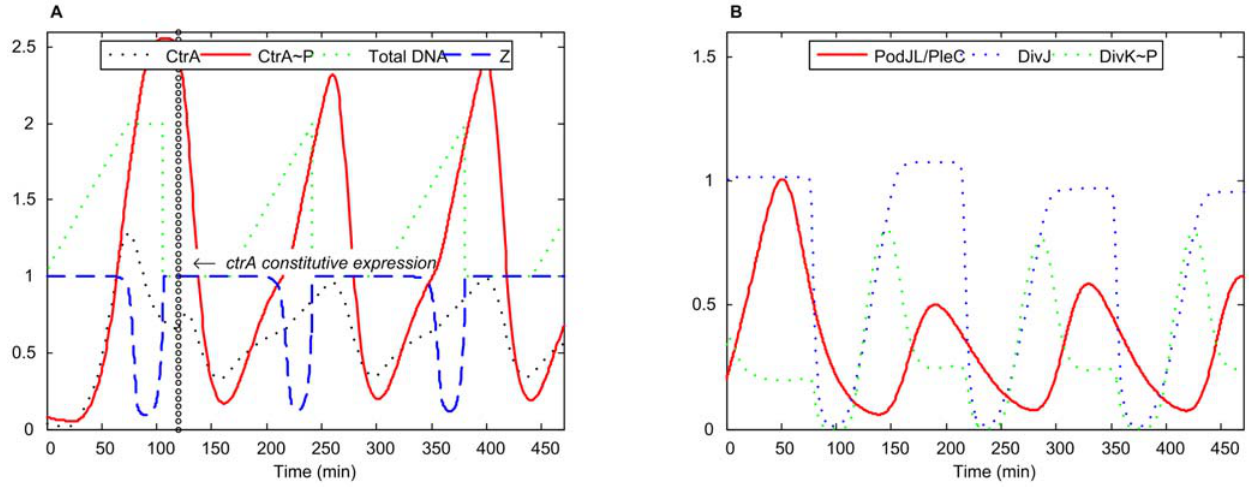
Figure 8. Simulation of ctrA constitutive expression. ctrA is constitutively expressed at 30% of its wild-type promoter activity: k s,ctrA-P1 = k s,ctrA-P2 =0, k 9 =0.048.